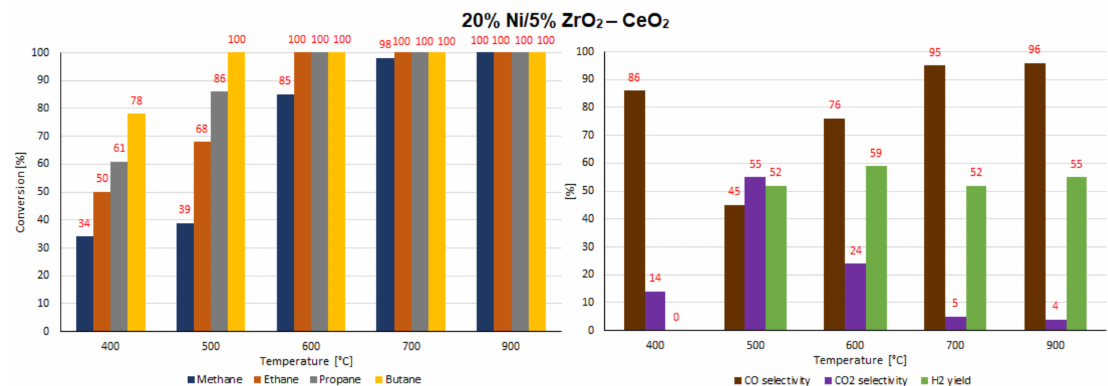
Figure 18. The activity results of the 20% Ni/5% ZrO 2 –CeO 2 catalyst in the OSR-LNG